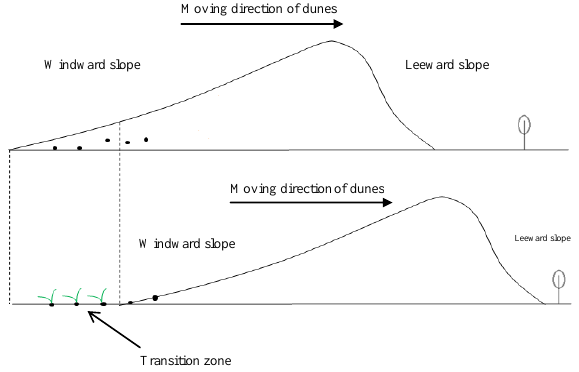
Figure 1. A sketch map showing the transition zone in inter-dune lowlands of an active sand dune system (modified from Yan et al.,